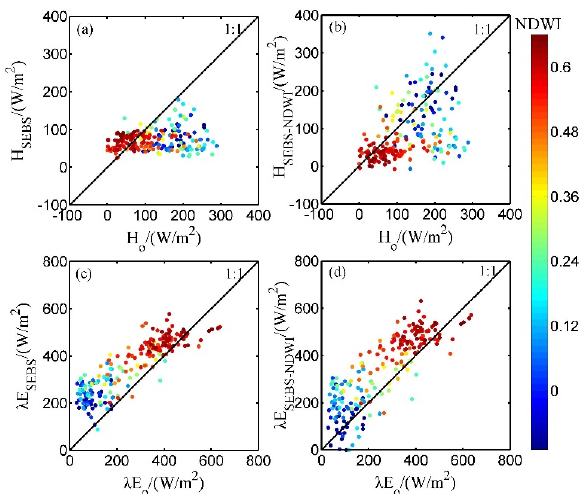
Figure 4. Comparison of the modeled and observed surface turbulent fluxes at the Yingke station in 2008–2011. ( a ) and ( b ) show scatter plots of the measured and observed sensible heat fluxes from the original SEBS and the NDWI-integrated SEBS, respectively; ( c ) and ( d ) show scatter plots of the measured and observed latent heat fluxes from the original SEBS and the NDWI-integrated SEBS, respectively.